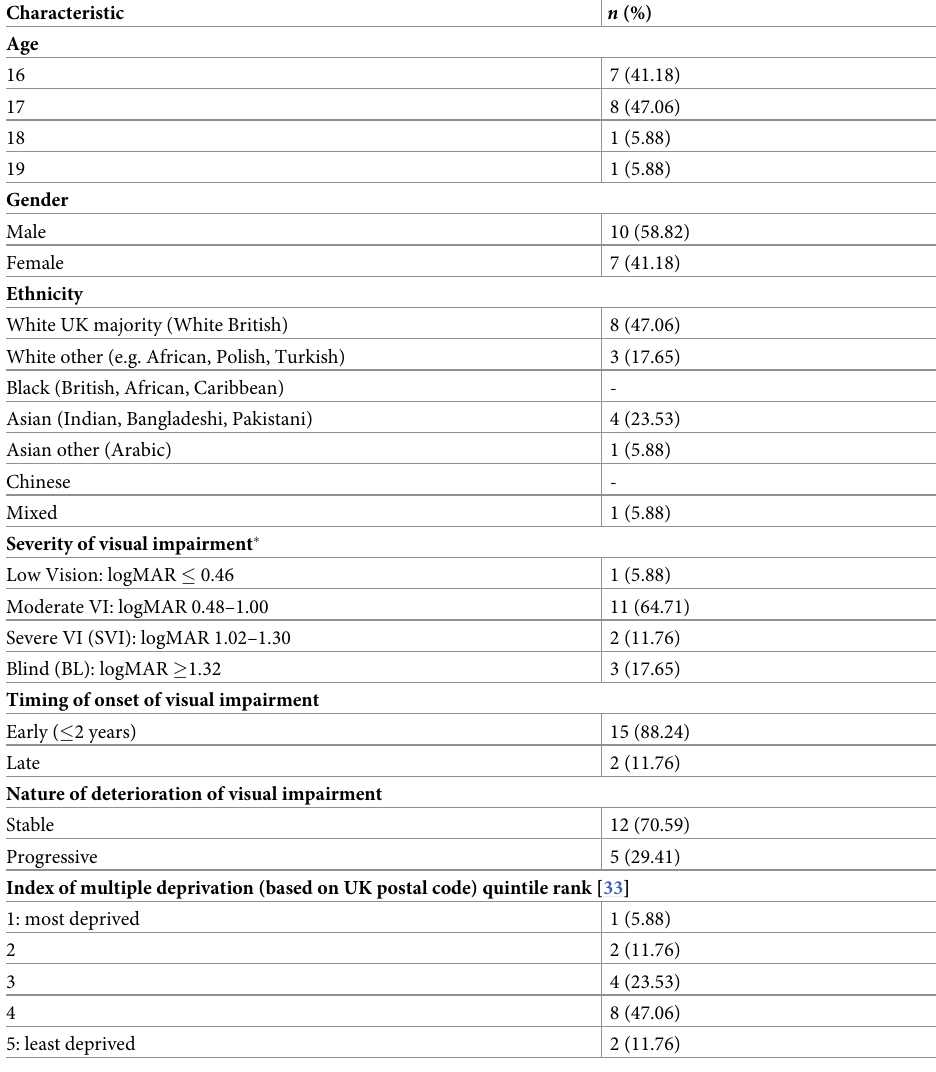
Table 1. Demographic and clinical characteristics of participants.